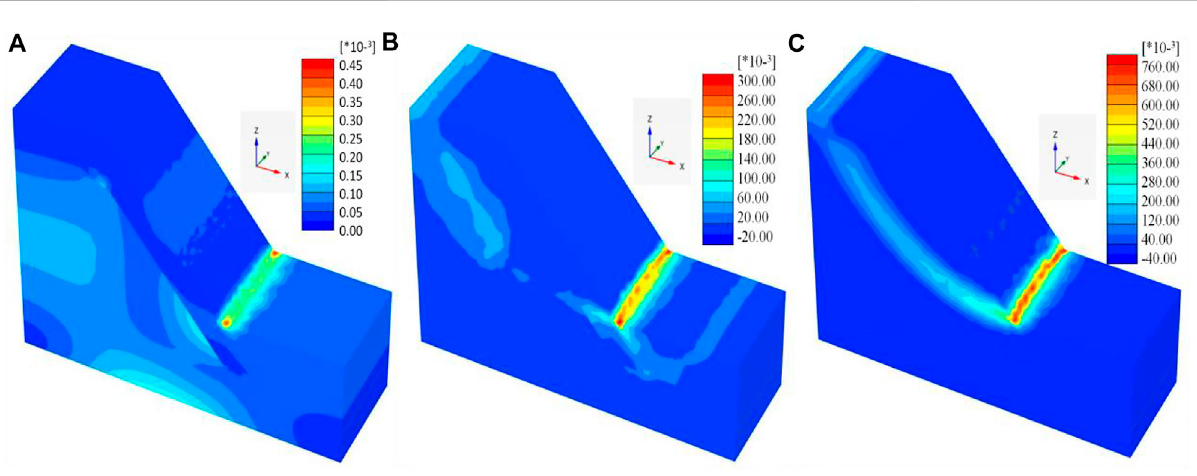
FIGURE 17 Cloud chart of slope shear strain (A) cloud chart ofshear strain at initial stage, (B) cloud chart of 1 h shearstrain, and (C) cloud chart of4 hshear strain.